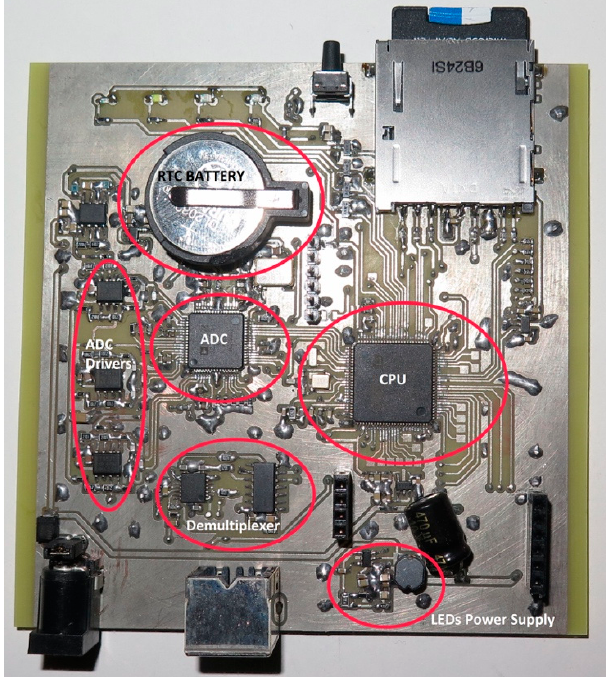
Figure 4. The multispectral recorder prototype. We circle and annotate the main components of the recorder.